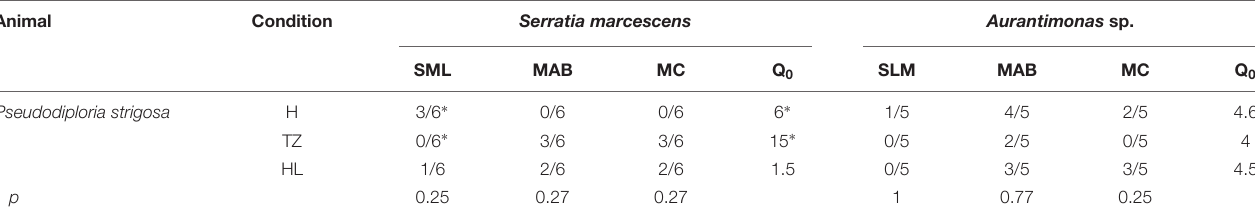
TABLE 1 | Frequency for the presence of inhibition growth zone of treated mucus collected from healthy or diseased Pseudodiploria strigosa (coral). Treated mucus was offered to plated tester strains Serratia marcescens and Aurantimonas sp., their growth inhibition scored after 16 and 48 h, respectively. Animal Condition